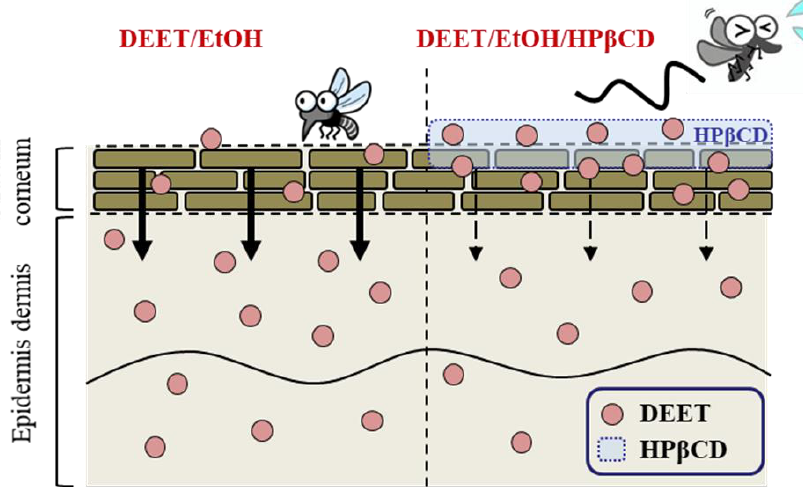
Figure 8. Graphical image for repellent action after the treatment with an insect repellent formulation based on DEET/EtOH/HPβCD.